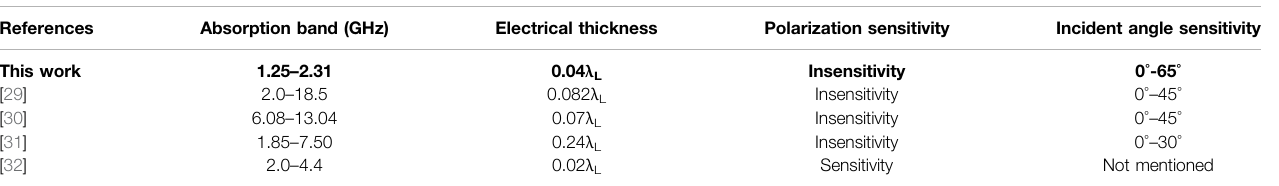
TABLE 1 | Simulated results of our proposed MA and recent